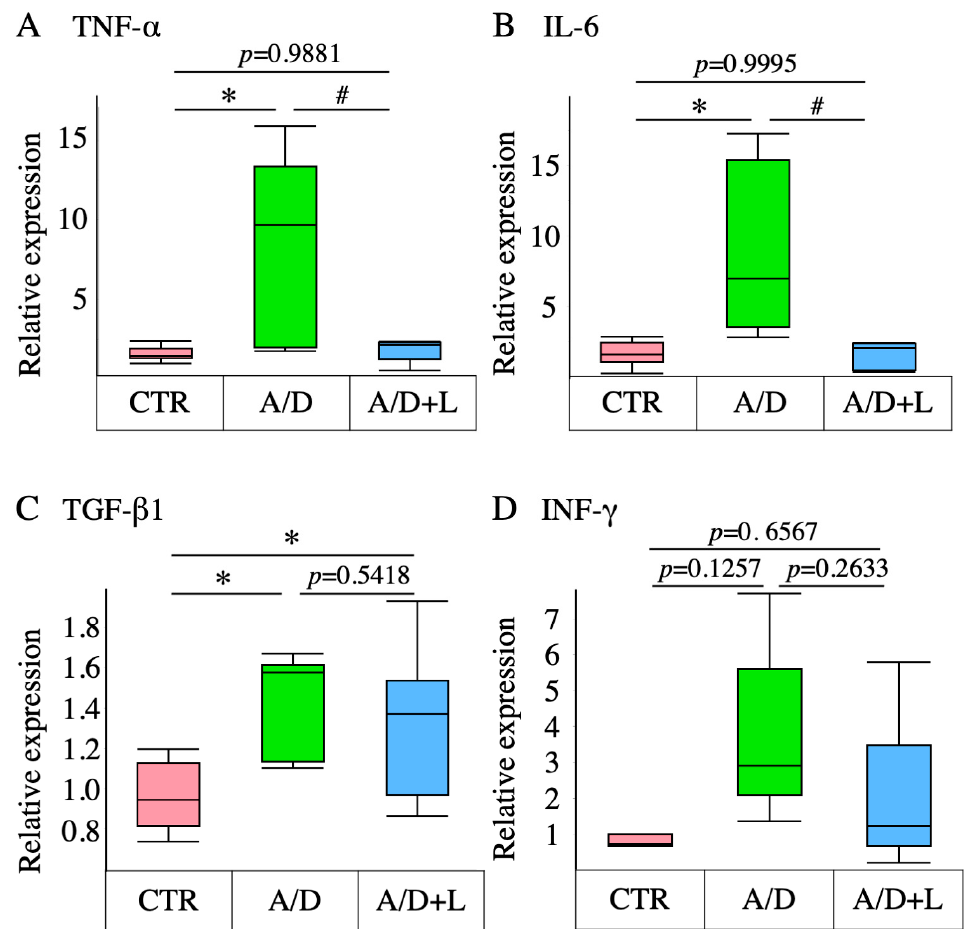
Figure 3. Effects of lactulose on the transcript-level expression of inflammatory cytokines in the AOM/DSS model. The transcript-level expression of tumor necrosis factor α (TNF- α ) ( A ), interleukin 6 (IL-6) ( B ), transforming growth factor β 1 (TGF- β 1) ( C ), and interferon γ (INF- γ ) ( D ) in the control (CTR), AOM/DSS (A/D), and AOM/DSS + lactulose (A/D+L) groups. Data are shown in boxplots ( n = 8). * p < 0.05 vs. CTR, # p < 0.05 vs. AOM/DSS.